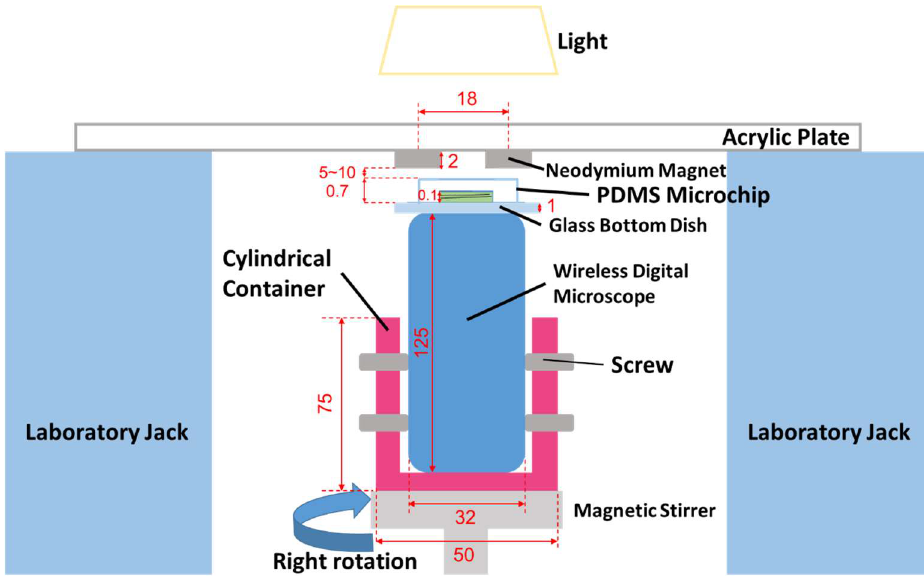
Figure 2. Schematic diagram of the observation system for the MMSB. All dimensions are in mm.